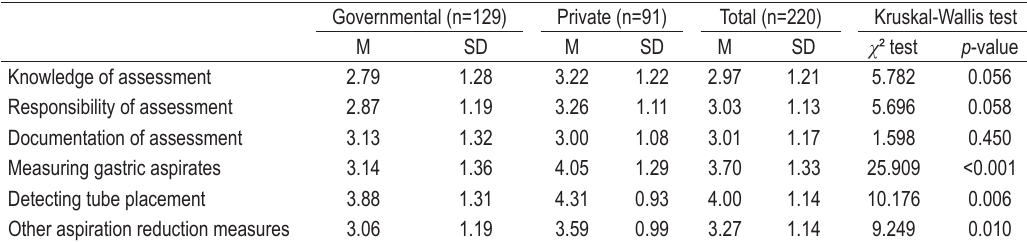
Table 2. Attitude to nutritional